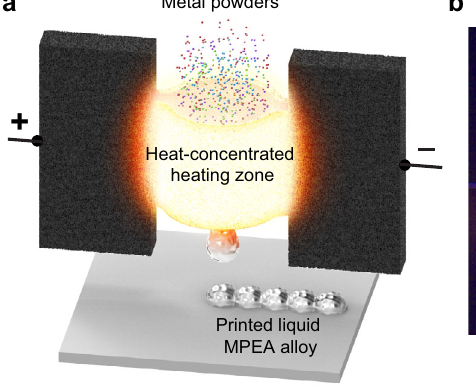
Fig. 1 | Ultrahigh-temperature melt printing platform for multi-elemental mixing to fabricate MPEAs. a Schematic of the ultrahigh-temperature, heat- concentrated platform for multi-elemental metal melt mixing towards the fabri- cation of MPEAs. Due to the higher electrical resistance of the heating zone, only thisareaof the carbon felt produces ahigh temperatureunder the applicationofa voltage due to Joule heating. Multi-elemental metal powders are loaded